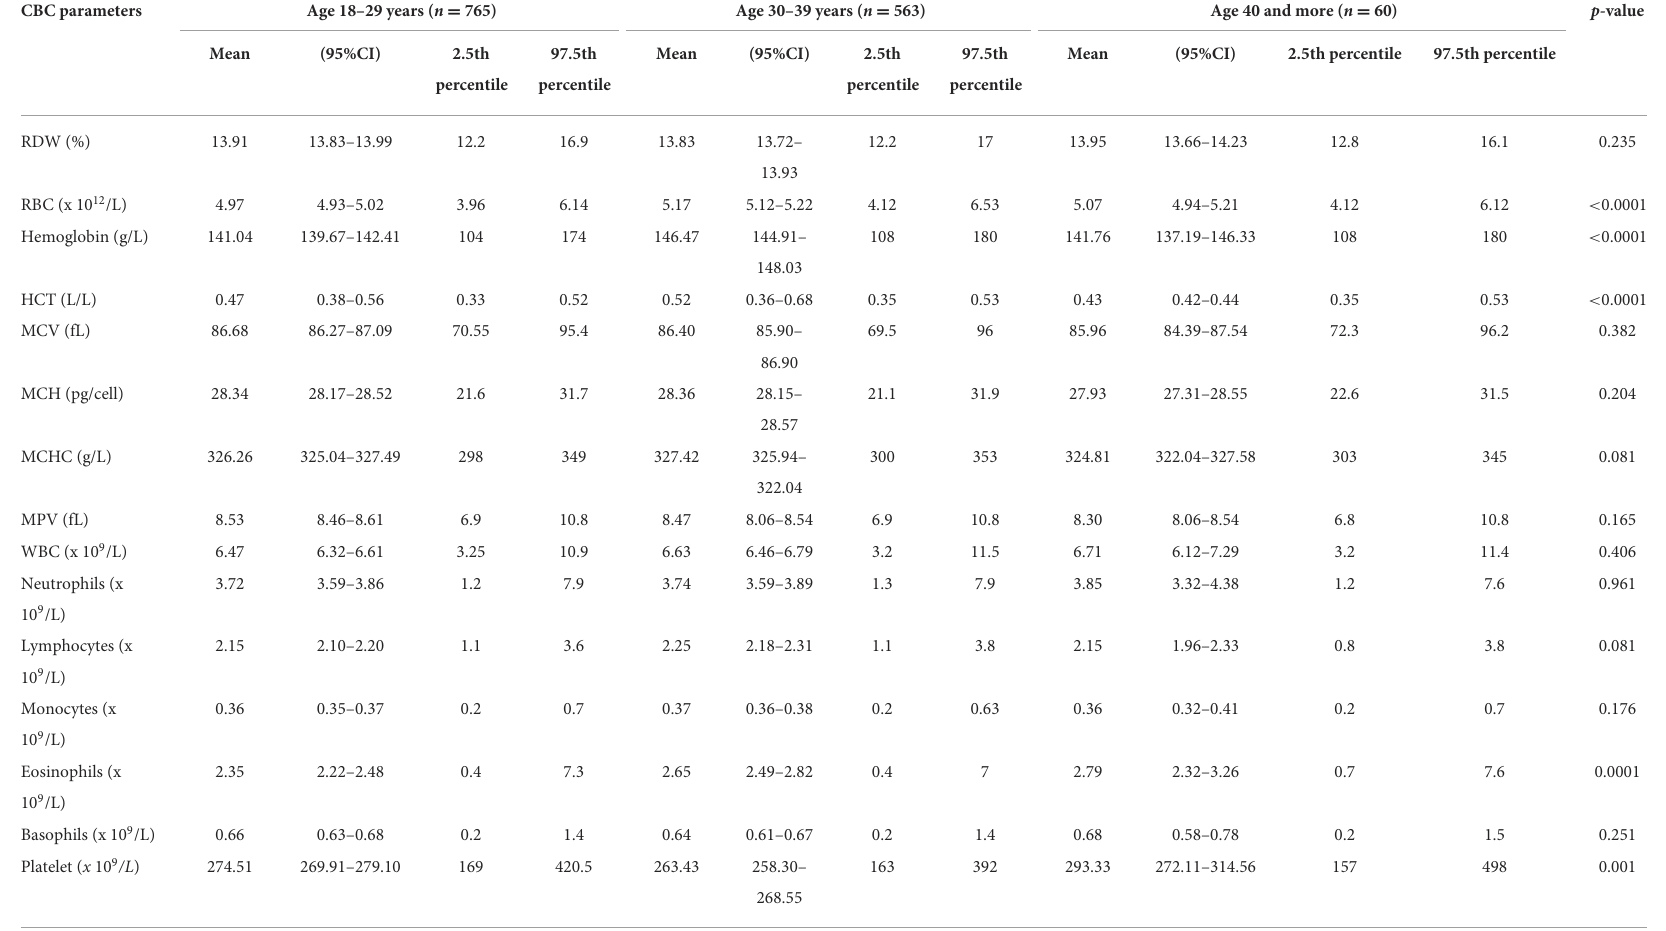
TABLE 2 The CBC reference intervals of the study cohort by age